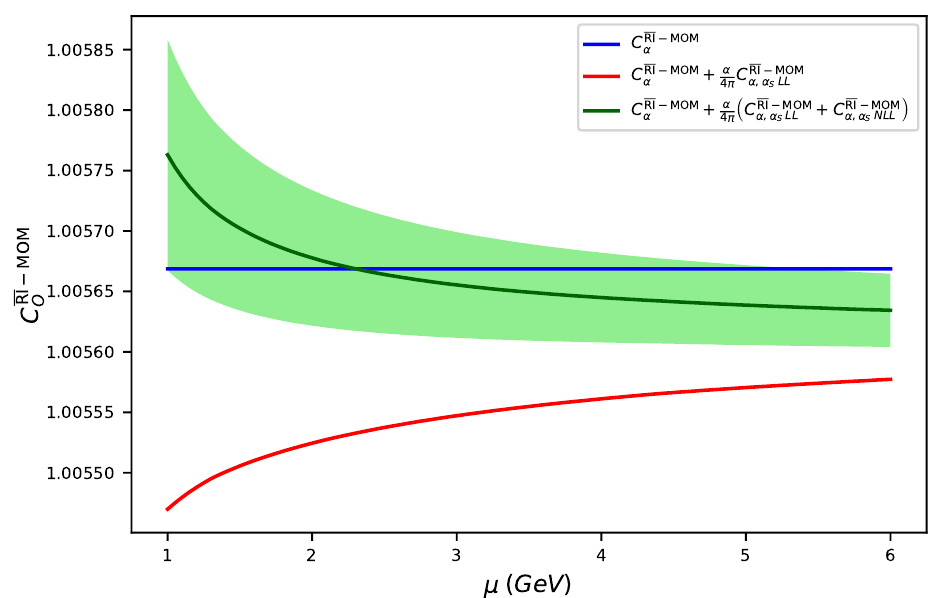
- , where we set MOM Figure 5. Residual scale dependence of the low-scale Wilson coefficient C RI O = 0 (dark green curve). We can see the reduction of the scale ξ = ξ s = 0 , − p 2 = 9 and γ (2) W dependence in going from C RI - MOM to C RI - MOM , while the residual scale dependence is dramatically α,α s LL α,α s NLL reduced compared to the RI 0 - MOM scheme (figure 4). The light green shaded area shows the effect of the unknown value of γ (2) on the next-to-leading-log contribution: the upper limit is obtained W with γ (2) = − 100 , while the lower limit is given by γ (2) W W